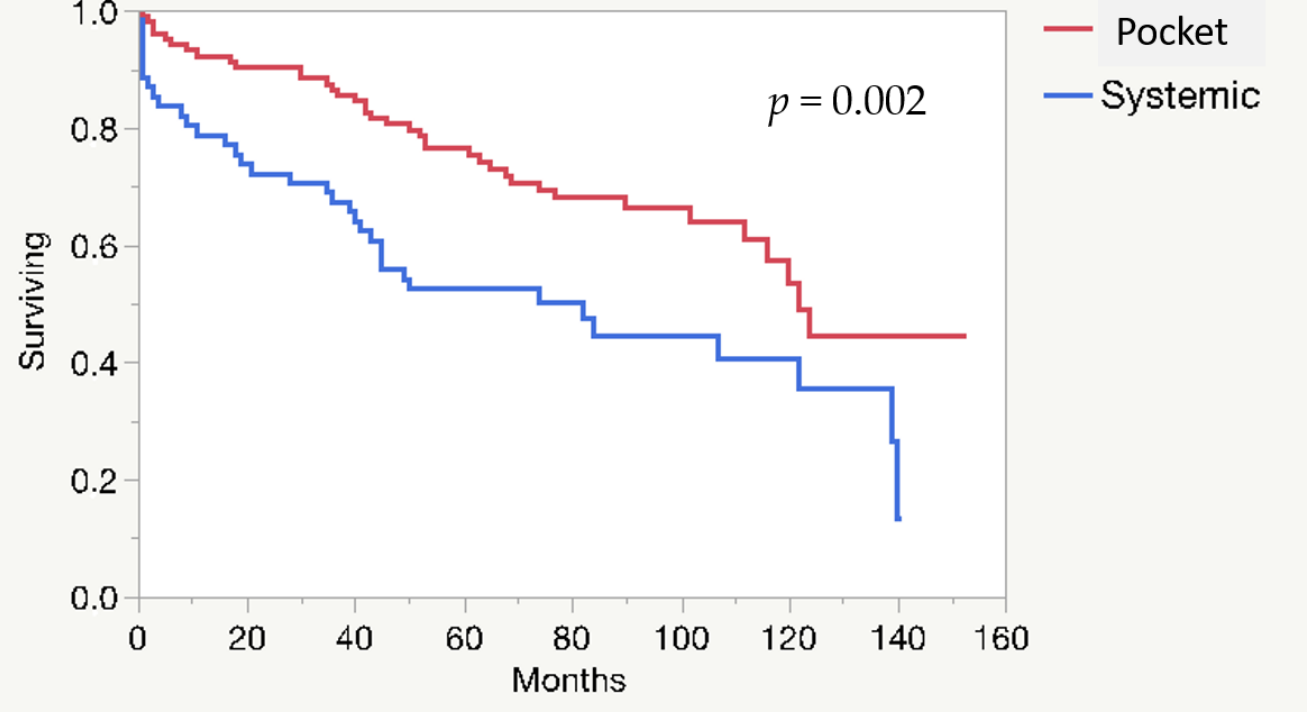
Figure 1. Long-term survival for patients with local and systemic CIED infection.